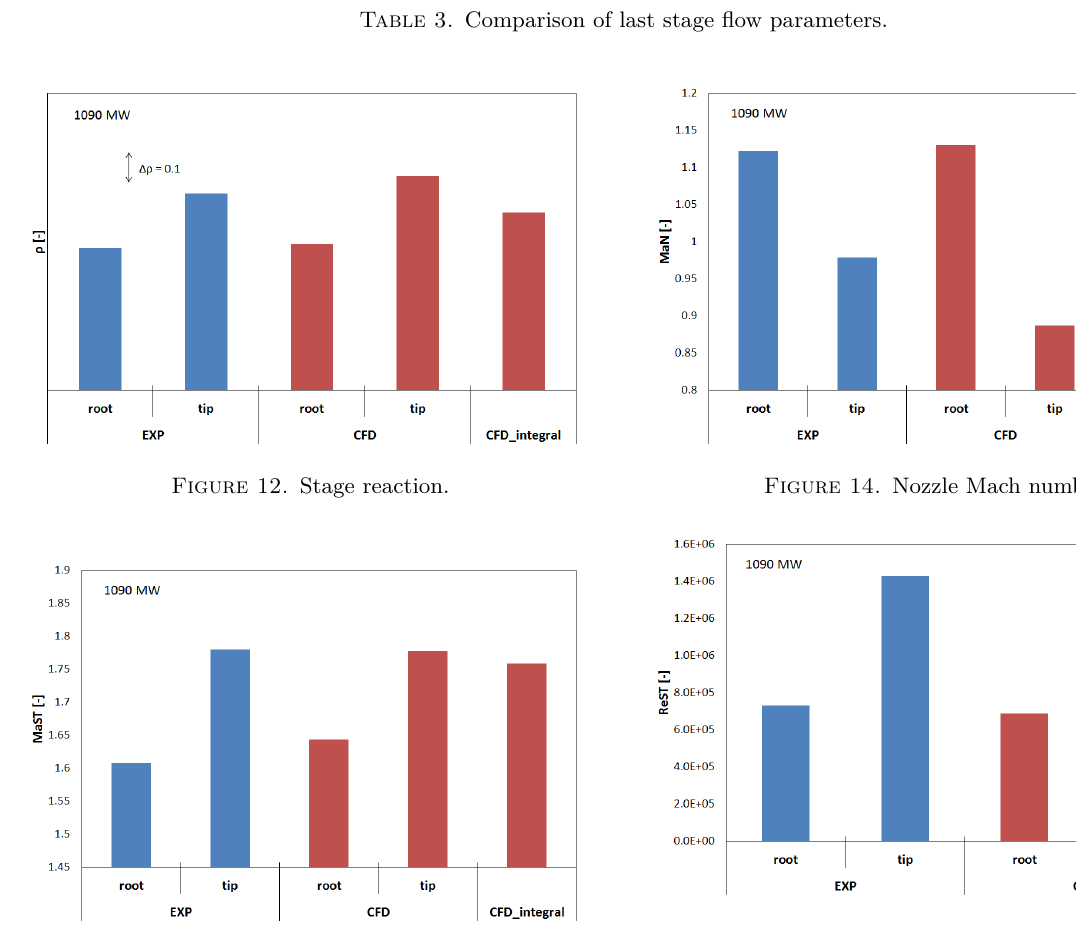
Figure 15. Stage Reynolds